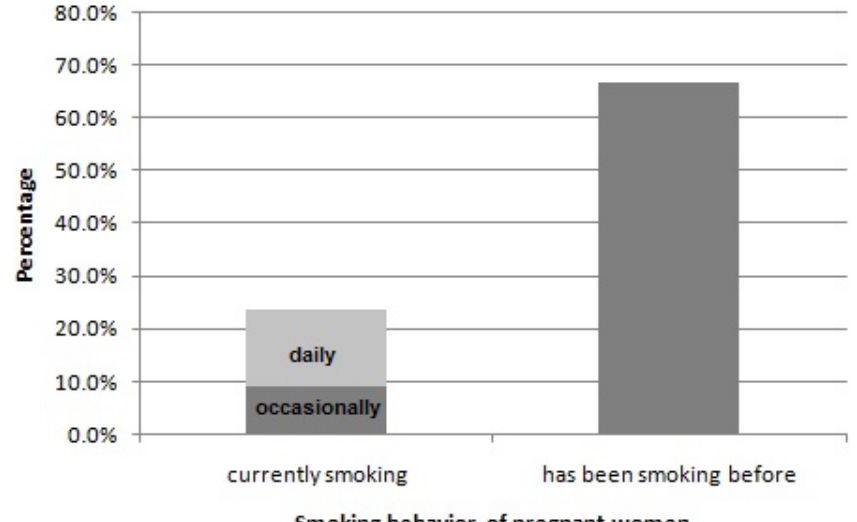
Figure 1. Written information on smoking behavior of 310 pregnant women in Berlin 2001–2002; with kind permission and modified after [4].